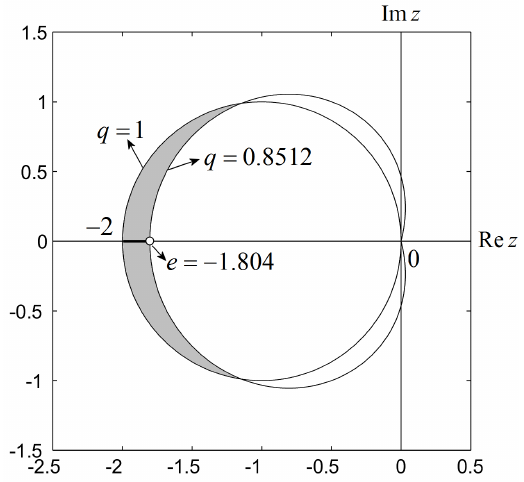
Figure 2. Stability domain S in the case of the fixed point X ∗ stability range of q for X ∗ 0